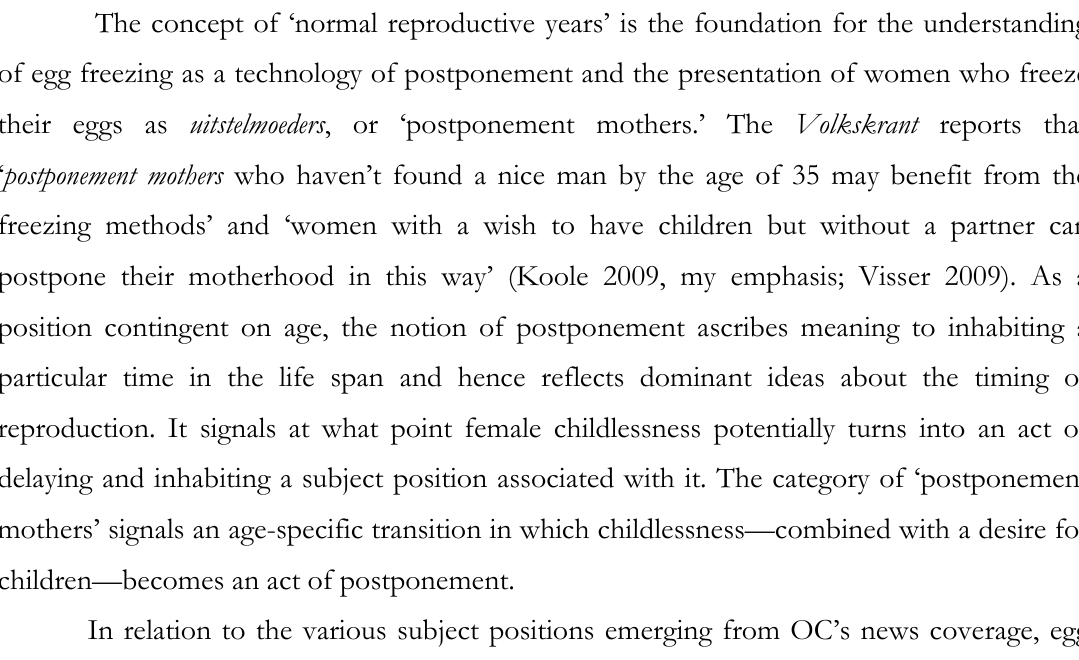
Lucy van de Wiel, For Whom The Clock Ticks: Reproductive Ageing and Egg Freezing in Dutch and British News Media Studies in the Maternal , 6(1), 2014,